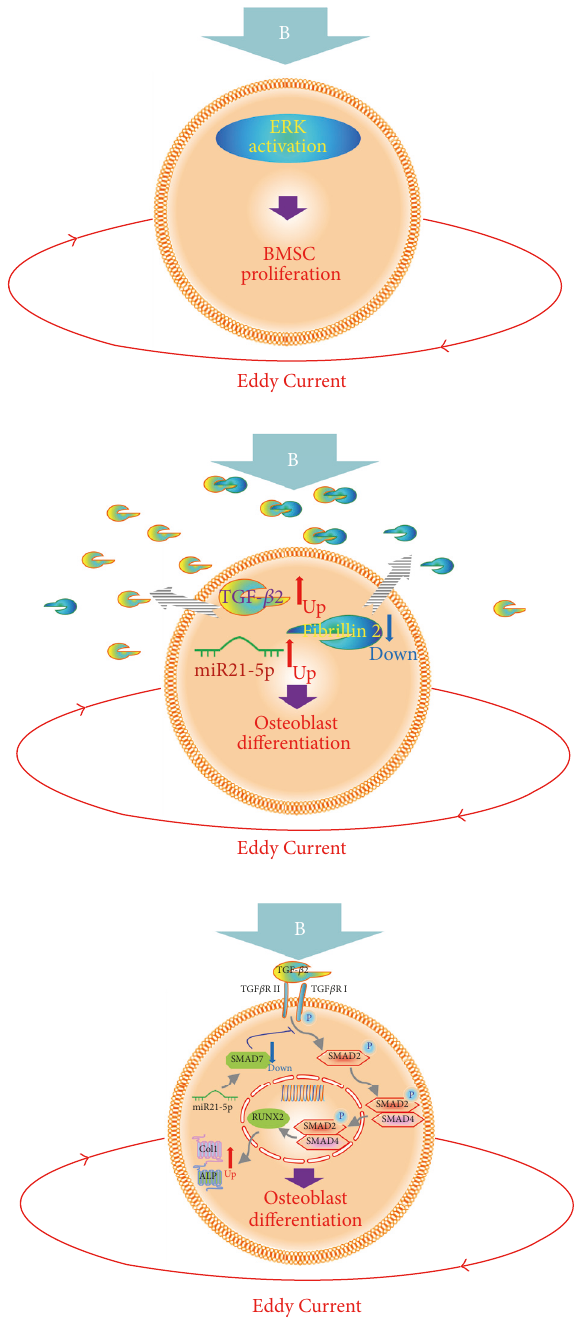
Figure 10: Schema of the mechanisms involved in PEMF stim- ulation of BMSC proliferation and osteoblast differentiation. The magnetic field (B) is thought to elicit Eddy Currents that act on BMSCs and cause activation of ERKs that are then involved in increased BMSC proliferation. After the BMSCs reach confluence and they are switched to differentiation medium, the magnetic field (B) and the resultant Eddy Currents cause a decrease in fibrillin 2 expression and an increase in TGF- 𝛽 2 and miR21-5p expression. The decrease in fibrillin 2 would lead to an increase in the amount of available TGF- 𝛽 2. The increase in miR21-5p appears to cause a decrease in inhibitory Smad7 expression, thus, enhancing TGF- 𝛽 2 activation of Smad2 with resulting increase in Runx2, collagen I, and alkaline phosphatase expression in the cultures, that is, increased osteoblast